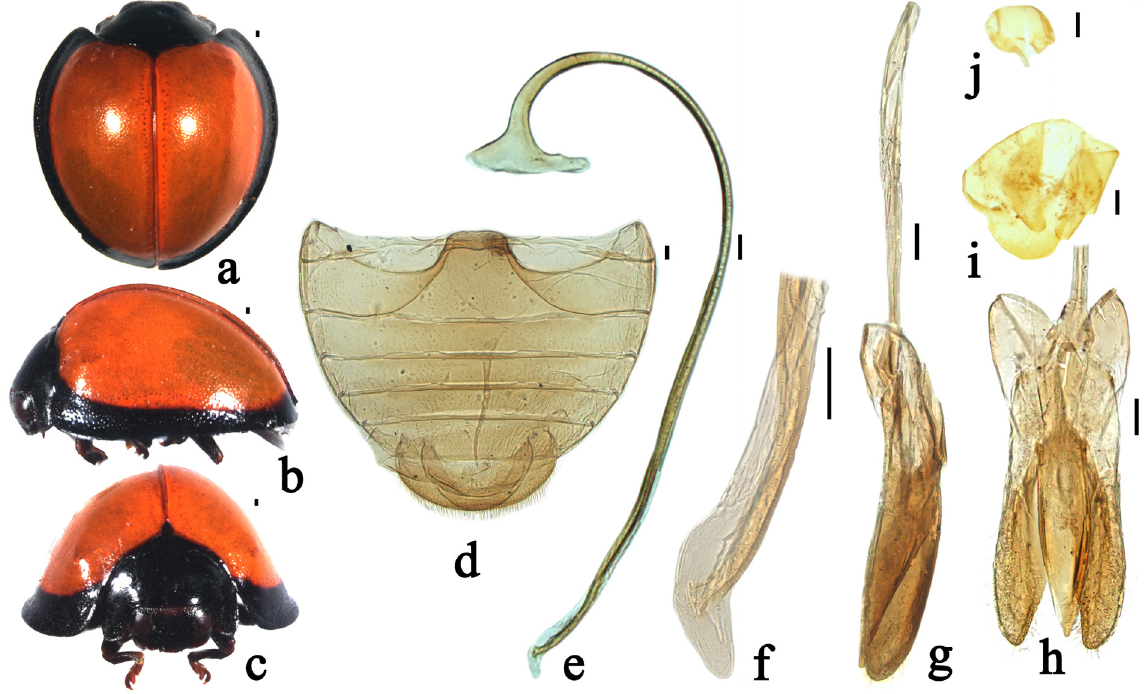
Fig. 9. Chilocorus hauseri Weise, 1895. a . Dorsal view. b . Lateral view. c . Frontal view. d . Abdomen. e . Penis. f . Apex of penis. g . Tegmen, lateral view. h . Tegmen, ventral view. i–j . Female genitalia. i . Ovipositor. j . Spermatheca. Scale bars: 0.1 mm.